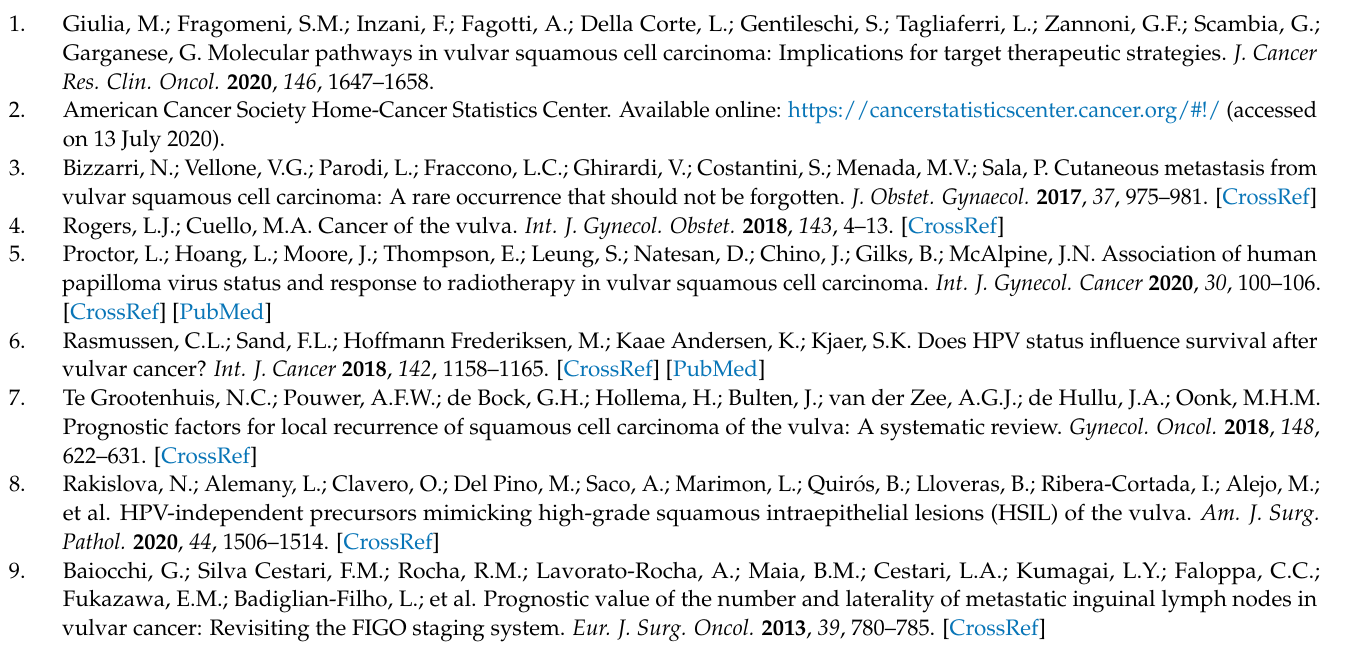
Table S2: Comparison of HPV types and co-infection in patients with VSCC; Table S3: Prevalence of HPV, considering patients with and without coinfection (n = 31); Table S4: VSCC clinicopathological features and CD9 protein expression; Table S5: VSCC clinicopathological features and CD63 protein expression using two categories (negative and positive expression); Table S6: Comparison between clinical and pathological features and CD63 protein expression using three categories (negative, moderate, and strong expression); Table S7: VSCC clinicopathological features and CD81 protein expression; Table S8: VSCC clinicopathological features and CD82 protein